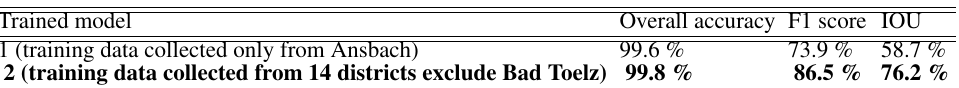
Table 3. Accuracy of two different trained models evaluated in Bad